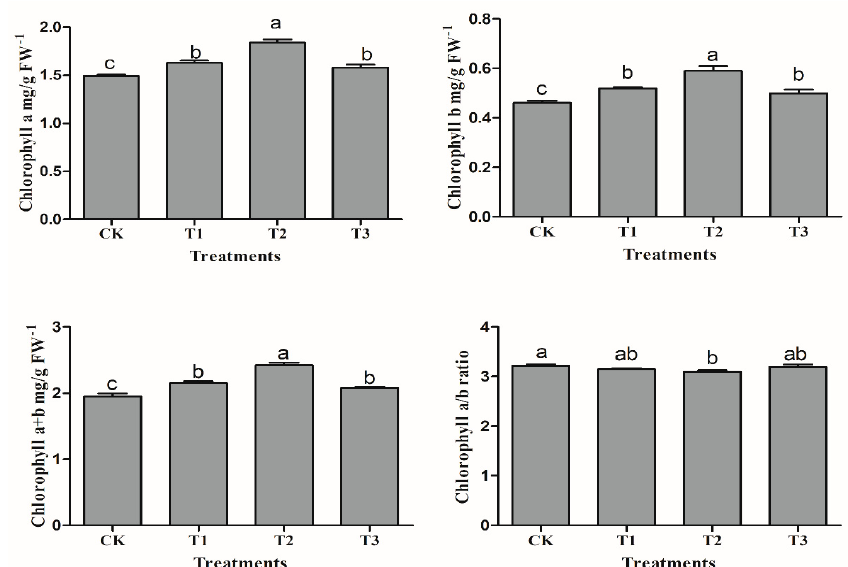
Figure 3. Effect of exogenous ALA application on chlorophyll contents of cucumber seedlings under low-temperature and weak-light stress. Data are the means of four replicates; error bars indicate the standard deviation. Treatments with the same lower-case letter are not significantly different (least significant difference test, p = 0.05).